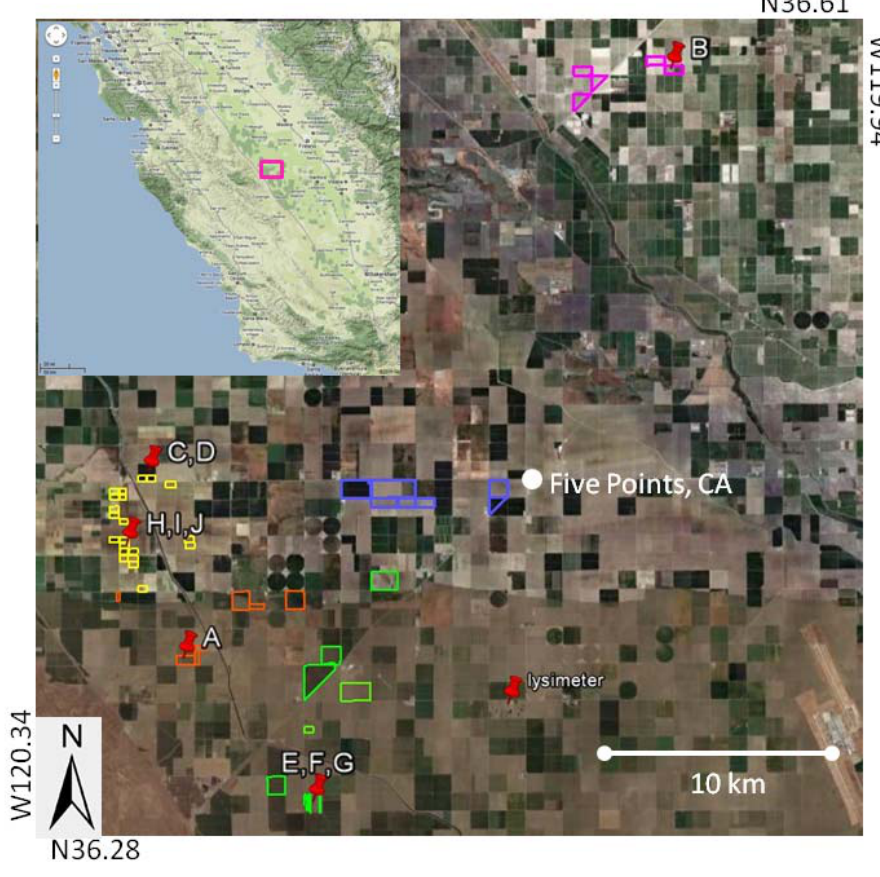
Figure 1. Study area. Polygons show fields used for objective #1 (NDVI-Fc relationship). Fields designated as A-J used for objective #2 (crop cycle monitoring) (see also table in Section 2.4). Location of WSREC lysimeter shown for